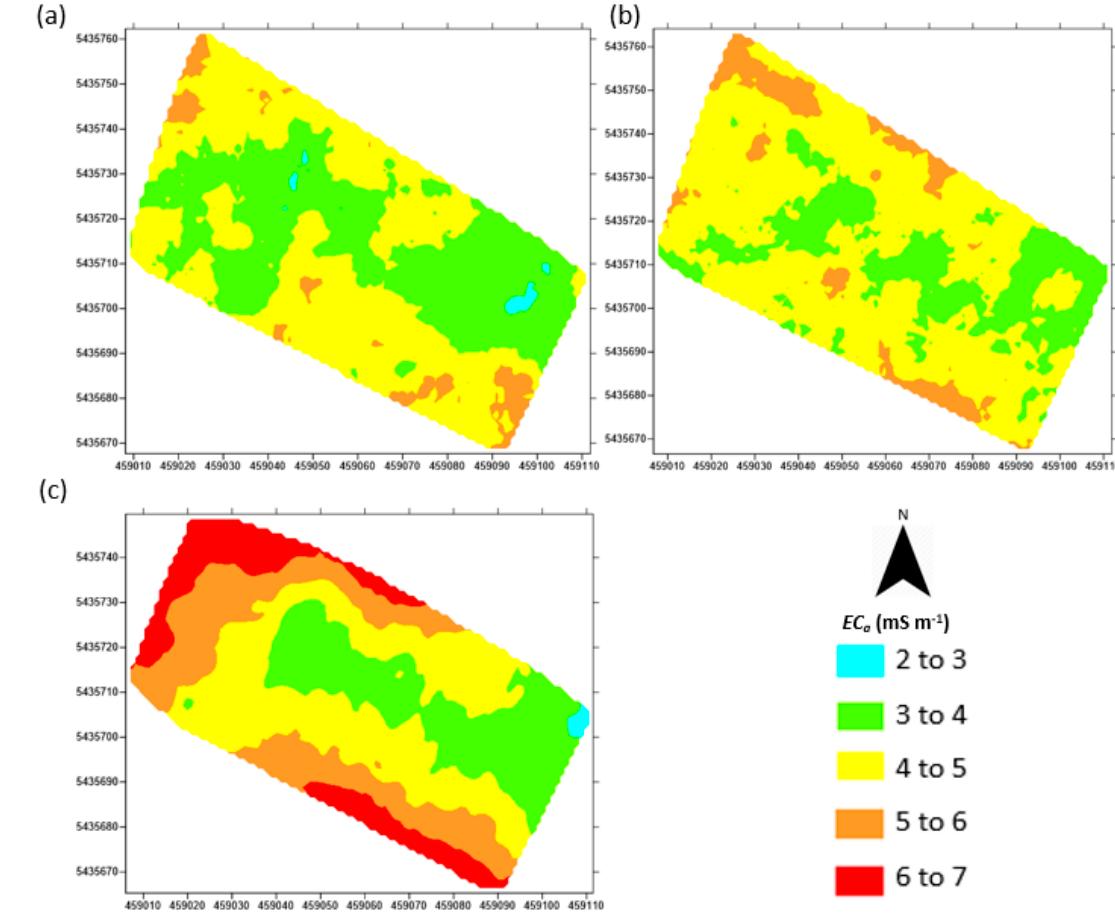
Figure 7. Spatial variability maps of EC a for the large field study ( a ) EC a - L ( b ) EC a - H ( c ) EC a - 38 kHz.